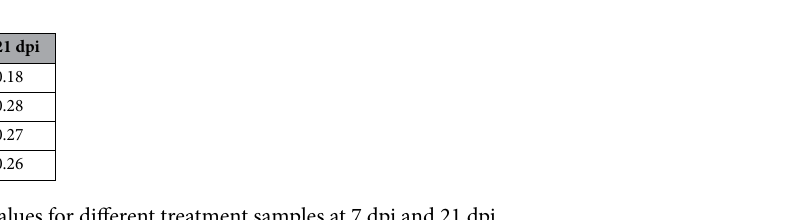
Table 1. Average F/B values for different treatment samples at 7 dpi and 21